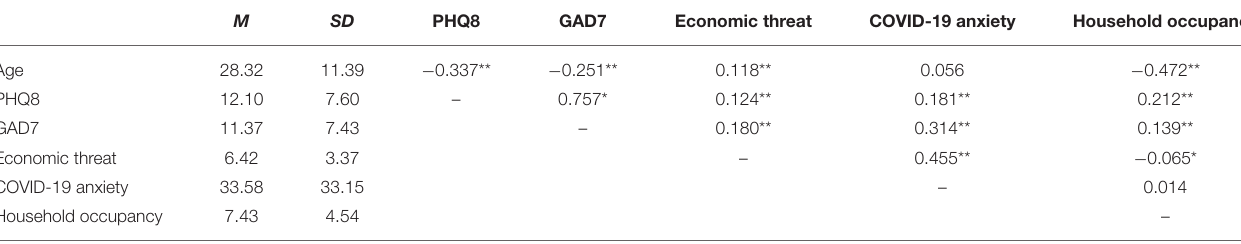
TABLE 4 | Means and bivariate correlations for all continuous